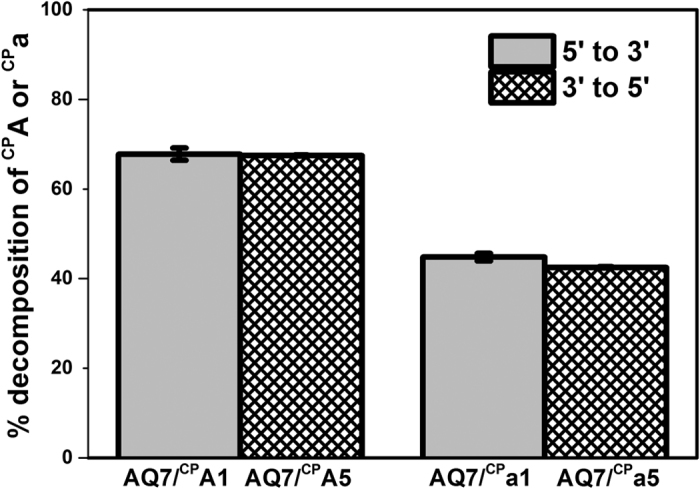
% Decomposition of CPA in AQ7/CPA1, AQ7/CPA5 and CPa in AQ7/CPa1, AQ7/CPa5 after irradiation for 10 s at 350 nm.Error bars are plotted along with the data.